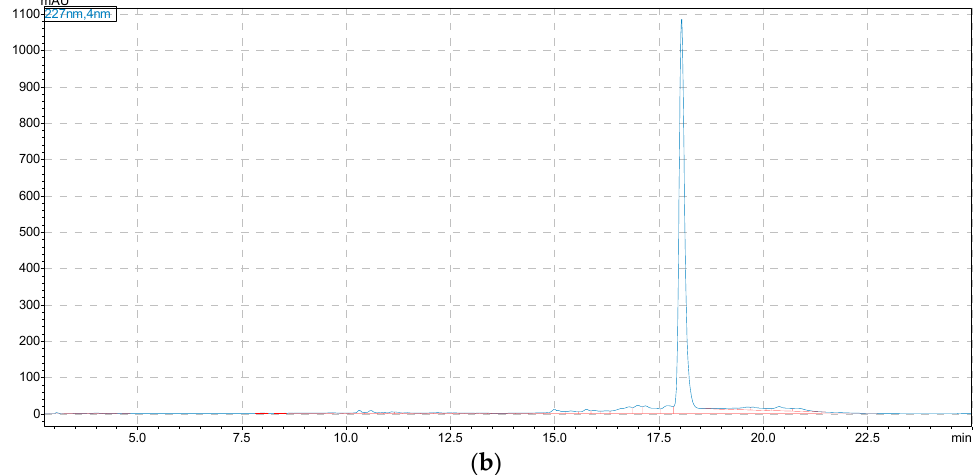
Figure 4. HPLC chromatogram of high-speed countercurrent chromatography (HSCCC) fractions for compound 1 ( a ) and compound 2 ( b ). Analytical column: Shimadzu Shim-pack GIST C 18 (250 × 4.6 mm, 5 µm, Shimadzu, Japan); mobile phase: ACN (A)-water (B), 0–30 min, 5–95% A; fl ow rate: 1.0 mL/min; detection: 227 nm.